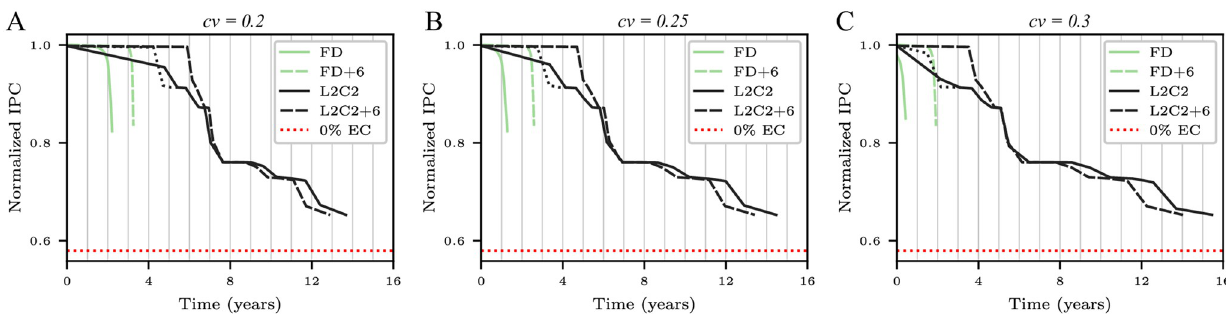
Fig 12. Normalized IPC evolution over time until 50% of capacity is lost for three different cv. cv = 0.2 (A), cv = 0.25 (B), cv = 0.3